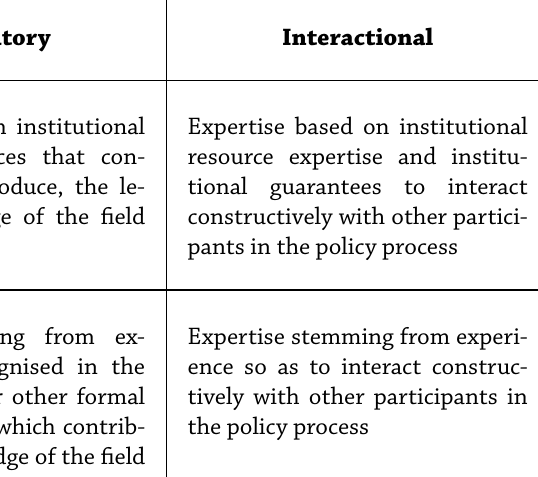
Table 1: Kinds of expertise Expertise Contributory Interactional